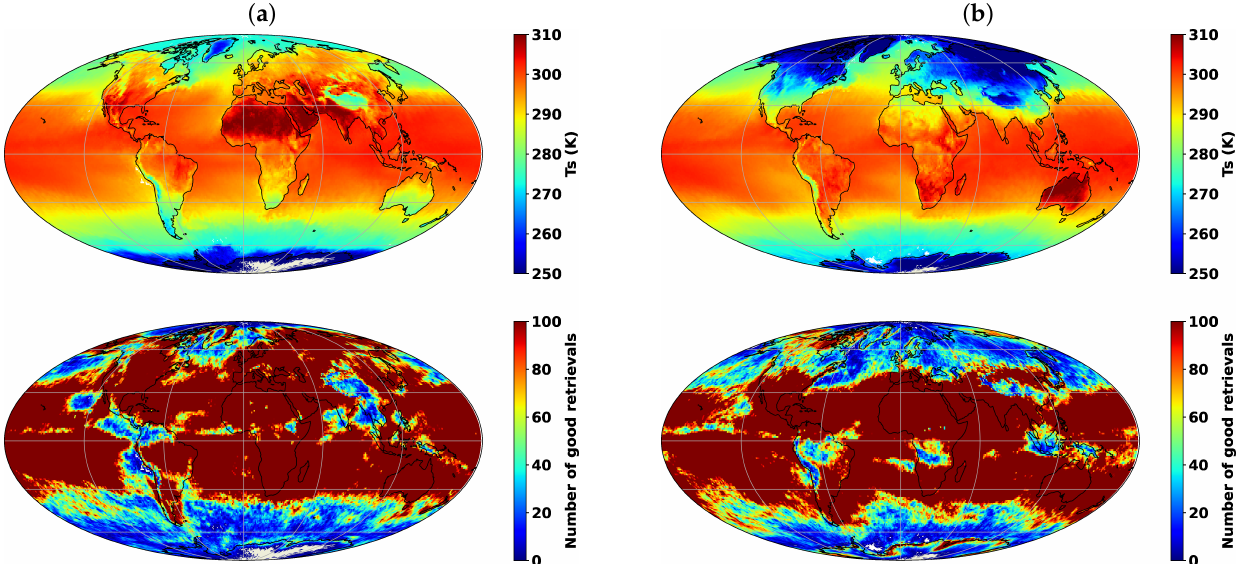
Figure 4. ( Top ) Retrieved surface temperature (monthly average) and ( bottom ) number of good retrievals per grid cell for ( a ) June and ( b ) December 2018, using a 1° × 1° lat/lon